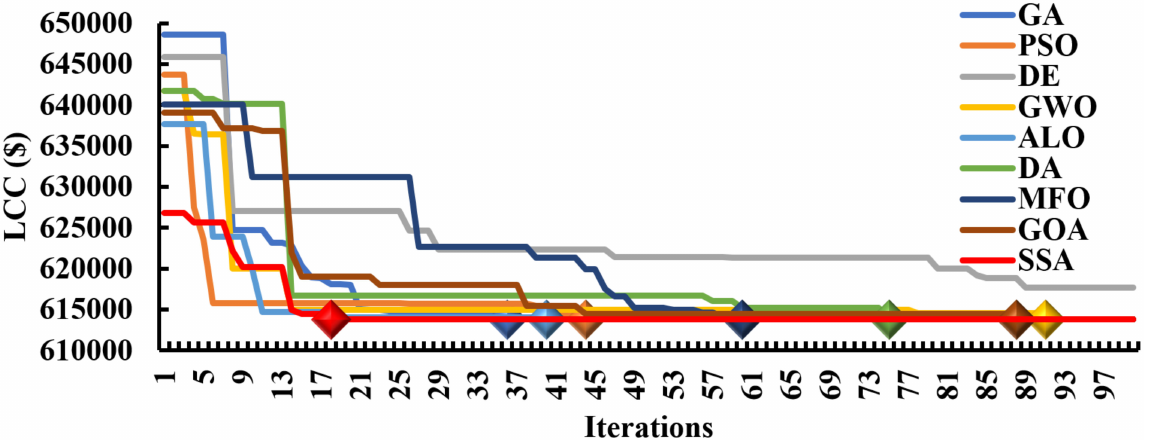
Figure 21. Convergence curves of Ni-Fe based IHRES with MPRAMC.